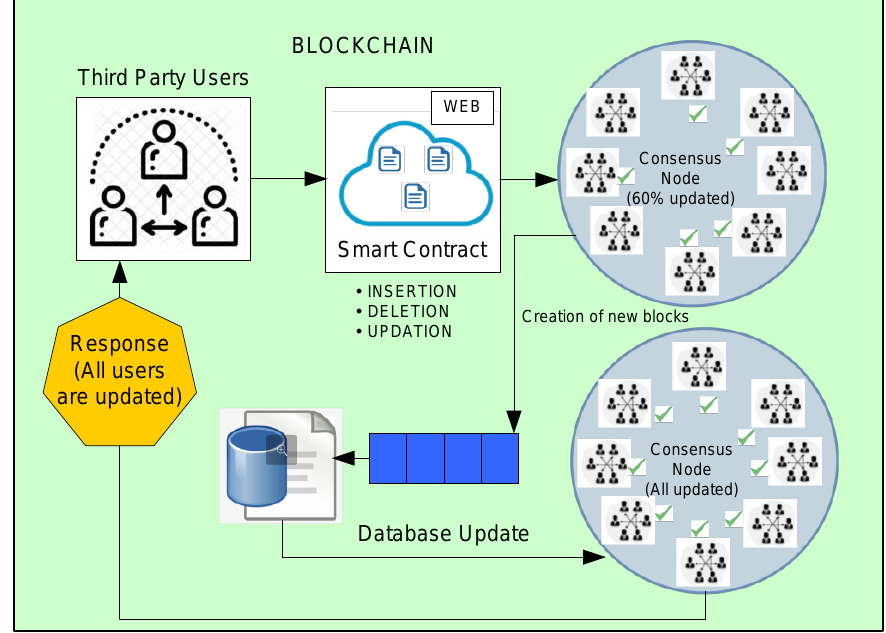
Figure 7 . Process of transaction of information along with smart contracts.